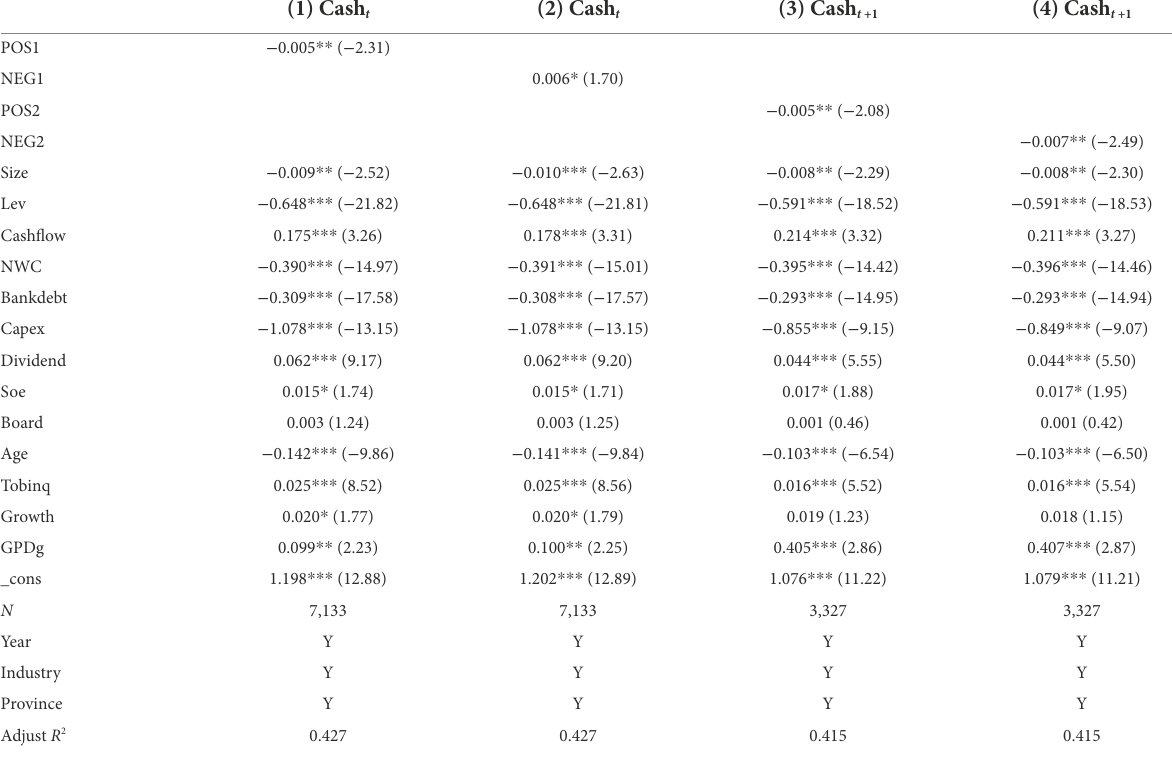
TABLE 8 COVID-19 impact, management tone and corporate cash holdings.